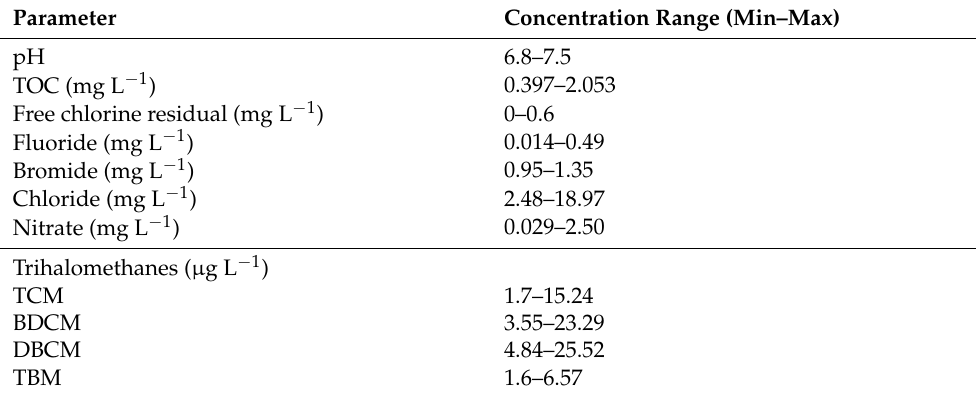
Table 2. Summary of water quality